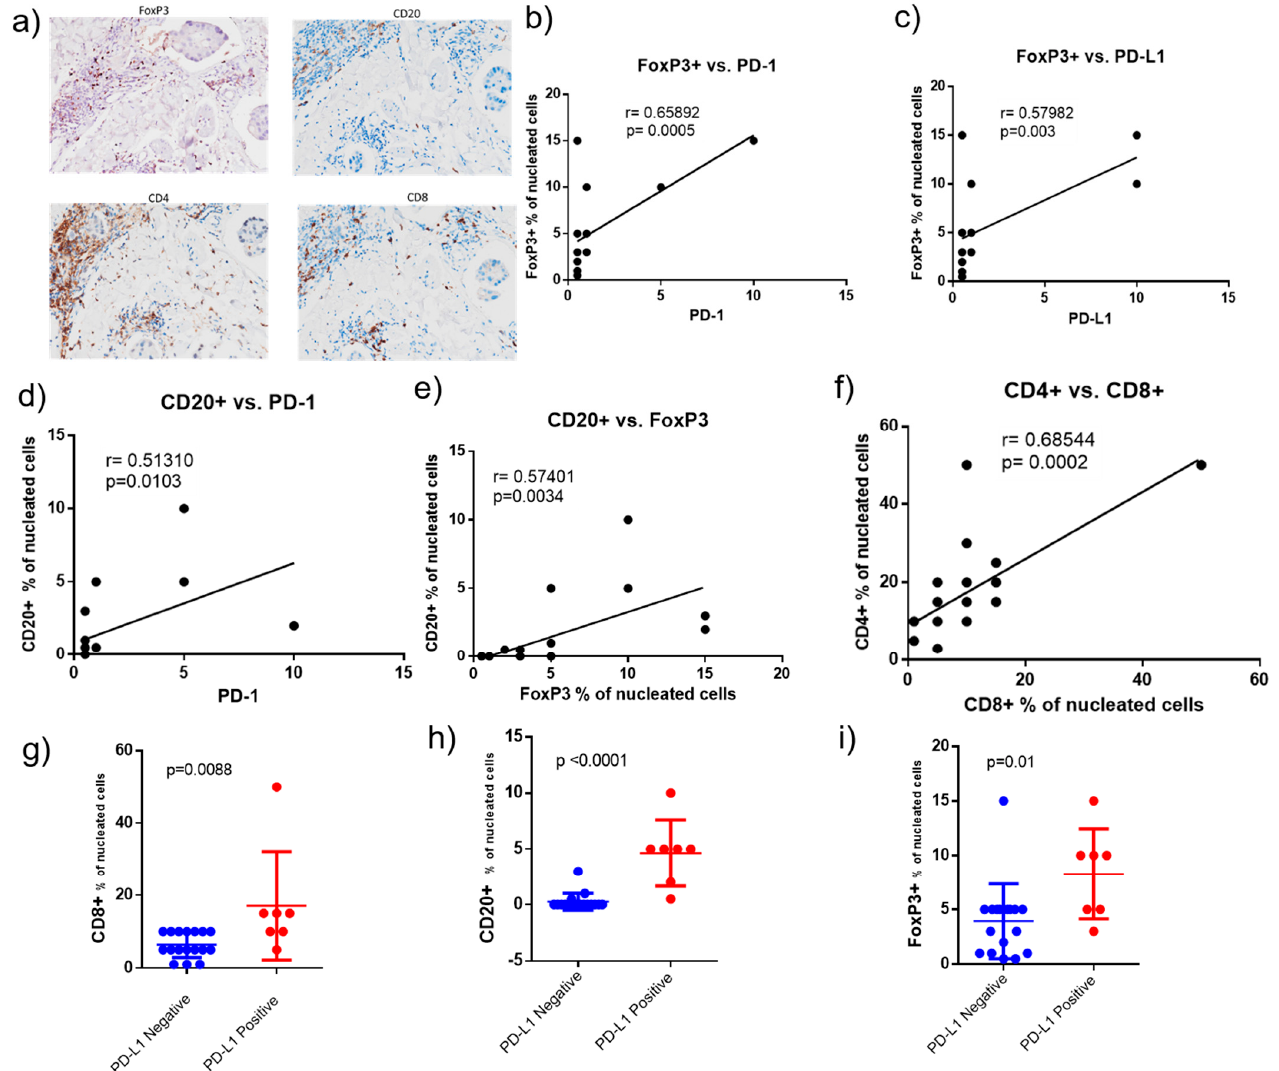
Figure 5. Tumor infiltrated lymphocytes in IBC. ( a ) Representative IHC for FoxP3 (Tregs), CD20+ (B cells), CD4+ (helper T cells) and CD8+ (cytotoxic T cells) cells are shown (200 × magnification). Correlation between markers was studied using the Spearman test. Correlation is shown for: ( b ) FoxP3+ cells and PD-1; ( c ) FoxP3+ cells and PD-L1; ( d ) CD20+ cells and PD-1; ( e ) CD20+ cells and FoxP3; ( f ) CD4+ and CD8+ cells. The percentage of different immune cells in PD-L1 negative and PD-L1 positive tumors are shown: ( g ) Percentage of CD8+ cells (cytotoxic T cells); ( h ) percentage of CD20+ cells (B-cells); ( i ) percentage of FoxP3+ (Tregs)